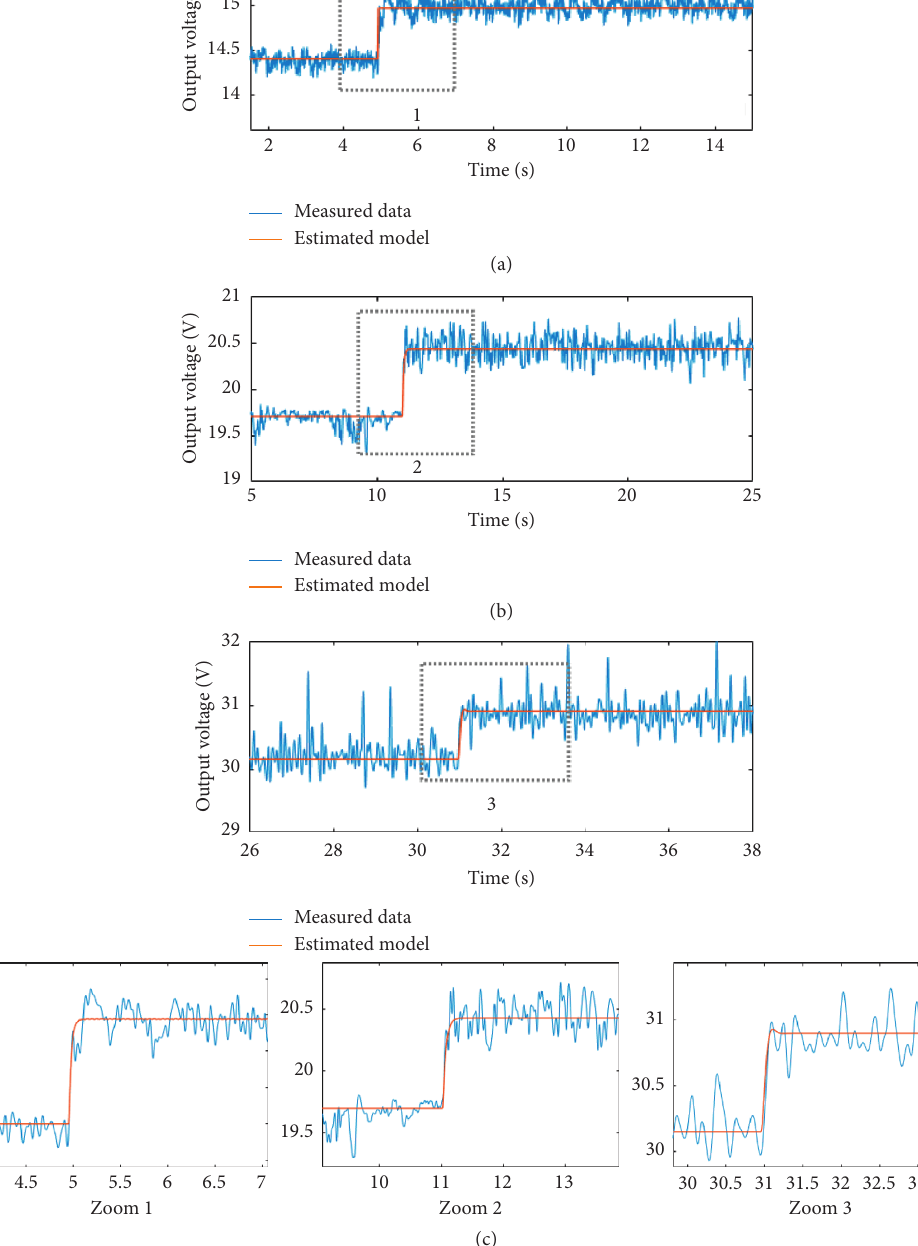
Figure 7: Output voltage response to duty cycle variations. (a) From 18% to 20%, (b) from 40% to 41%, and (c) from 60% to